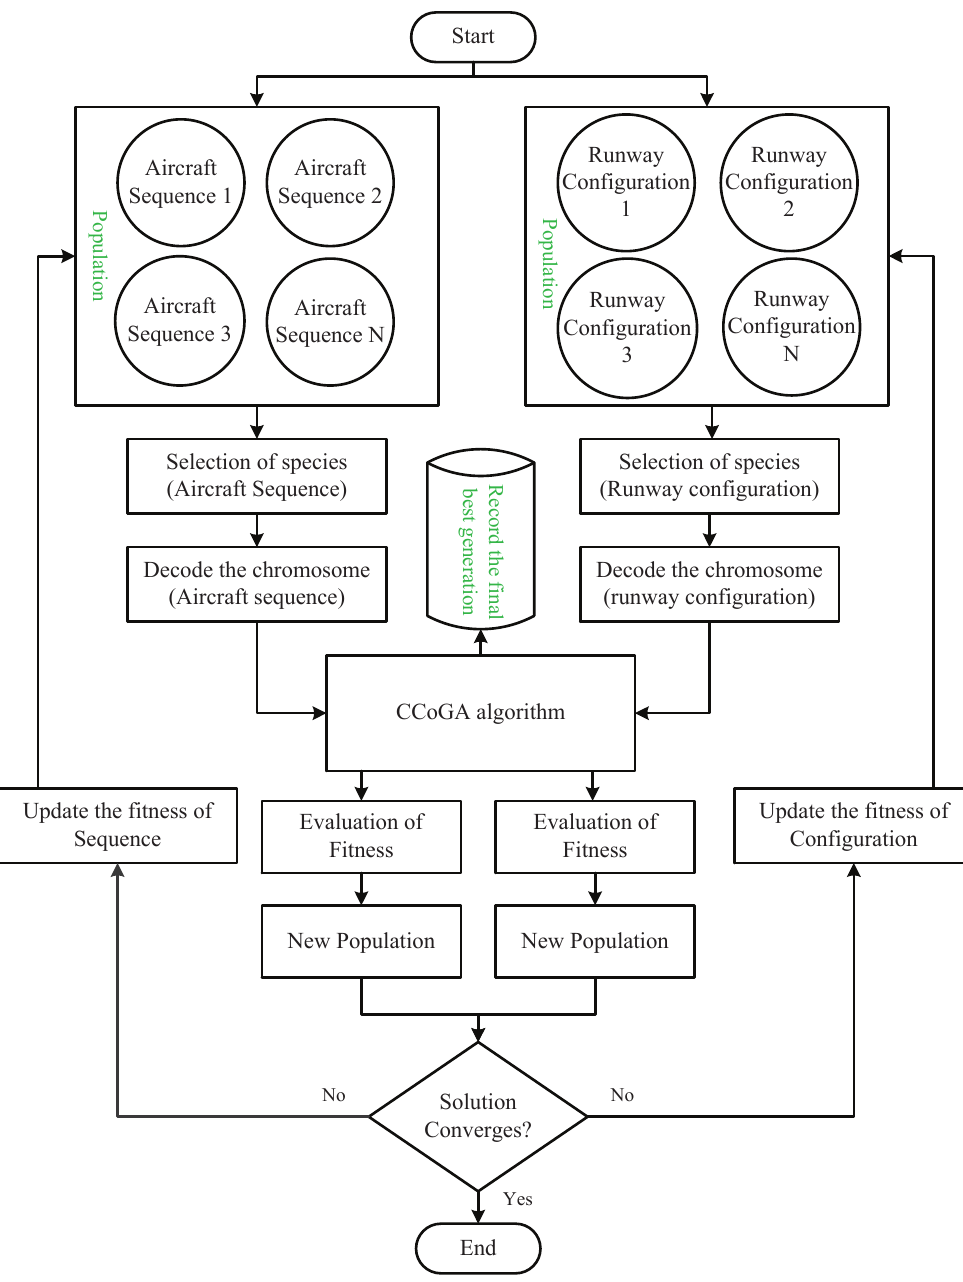
Figure 2. The process flow of the Cooperative Co-evolutionary Genetic Algorithm (CCoGA): two separate populations co-evolve mutually to achieve the best-fit sequence and runway